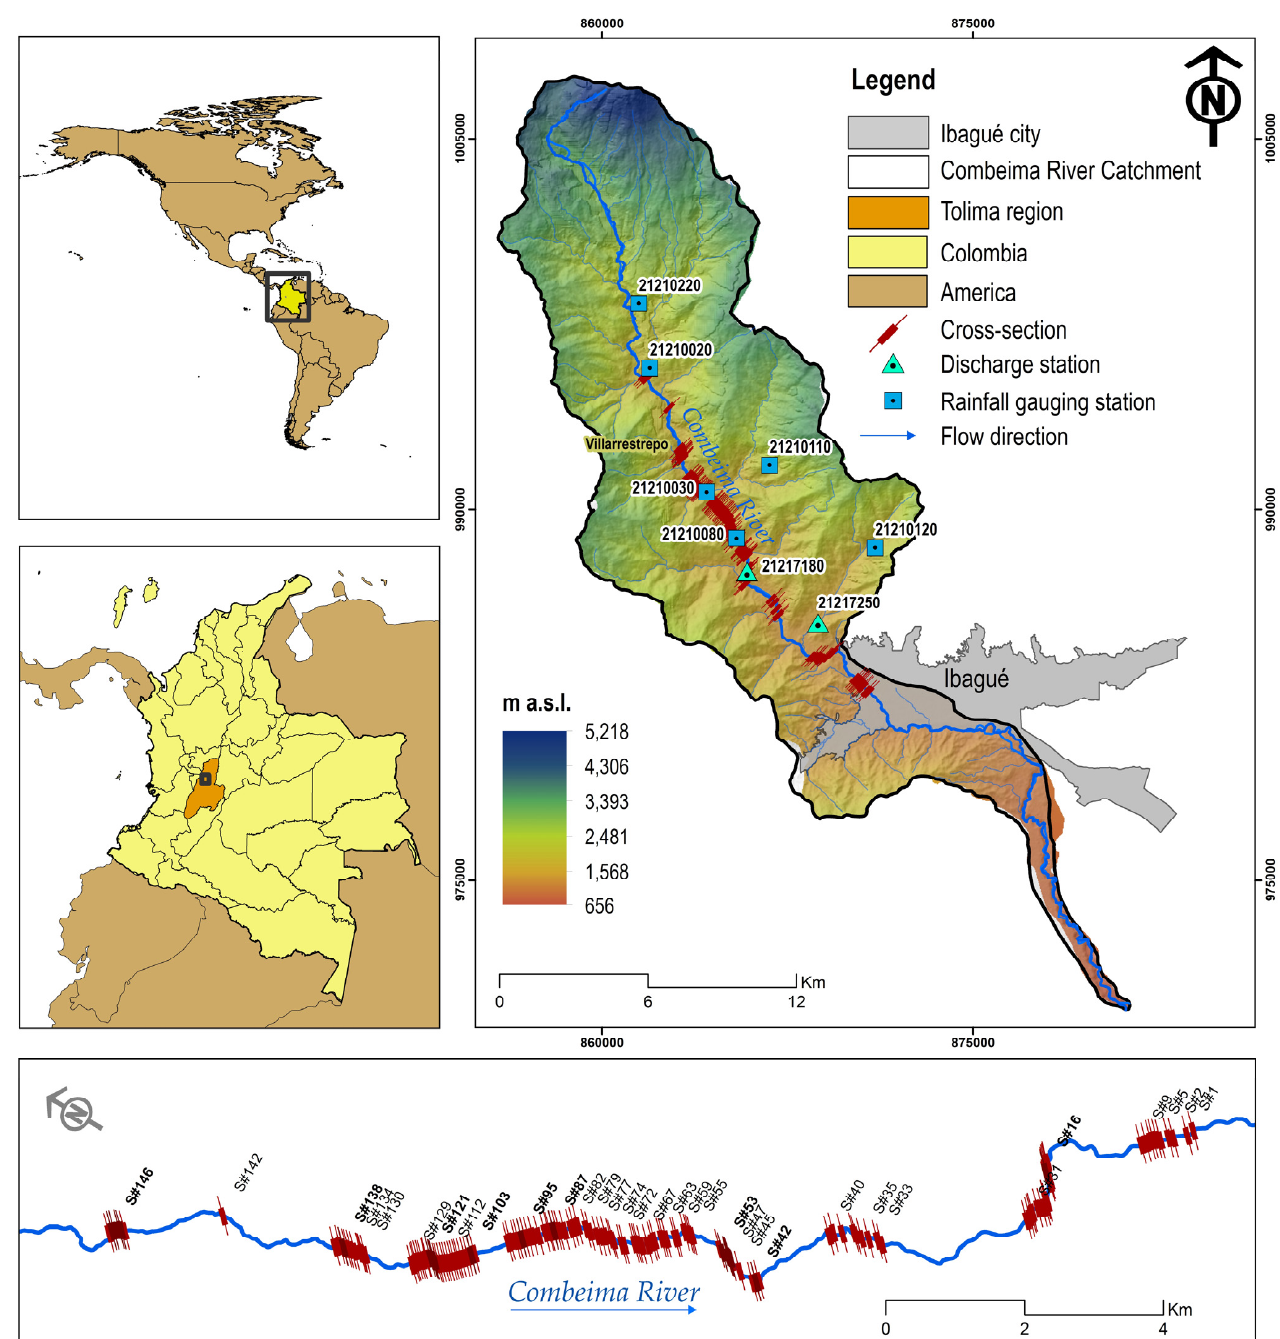
Figure 1. Location of the study area.